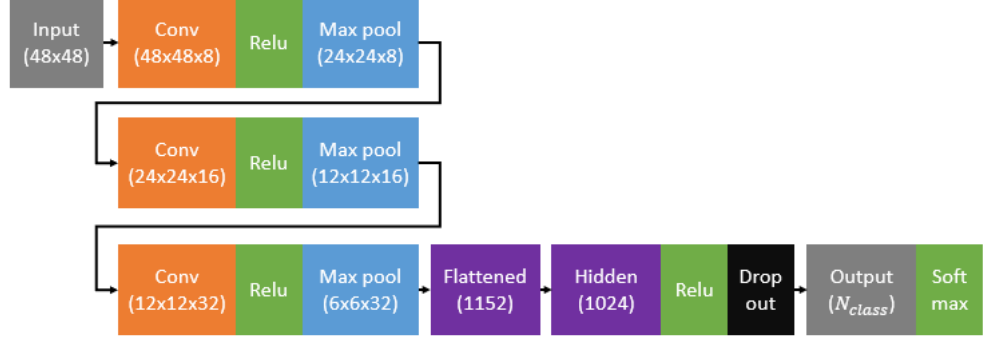
Figure 10. Architecture of the CNN.